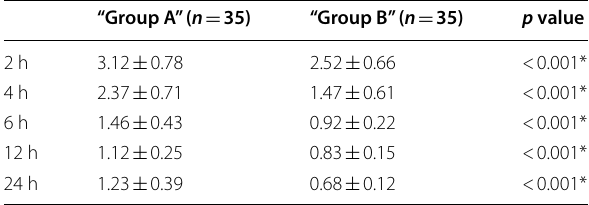
Table 2 Comparisons between the two groups regarding pain